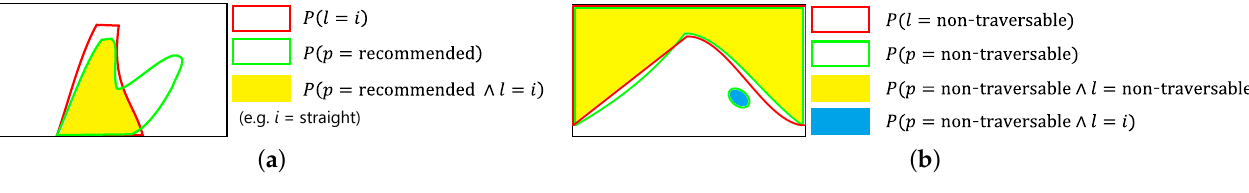
Figure 11. Image of evaluation area. ( a ) Evaluation area for R i . ( b ) Evaluation area for R nt and R m